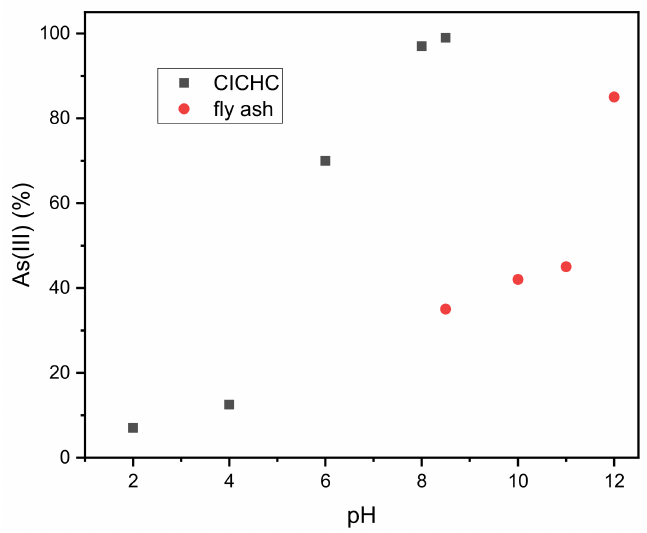
Figure 3. As(III) adsorption as a function of pH variation